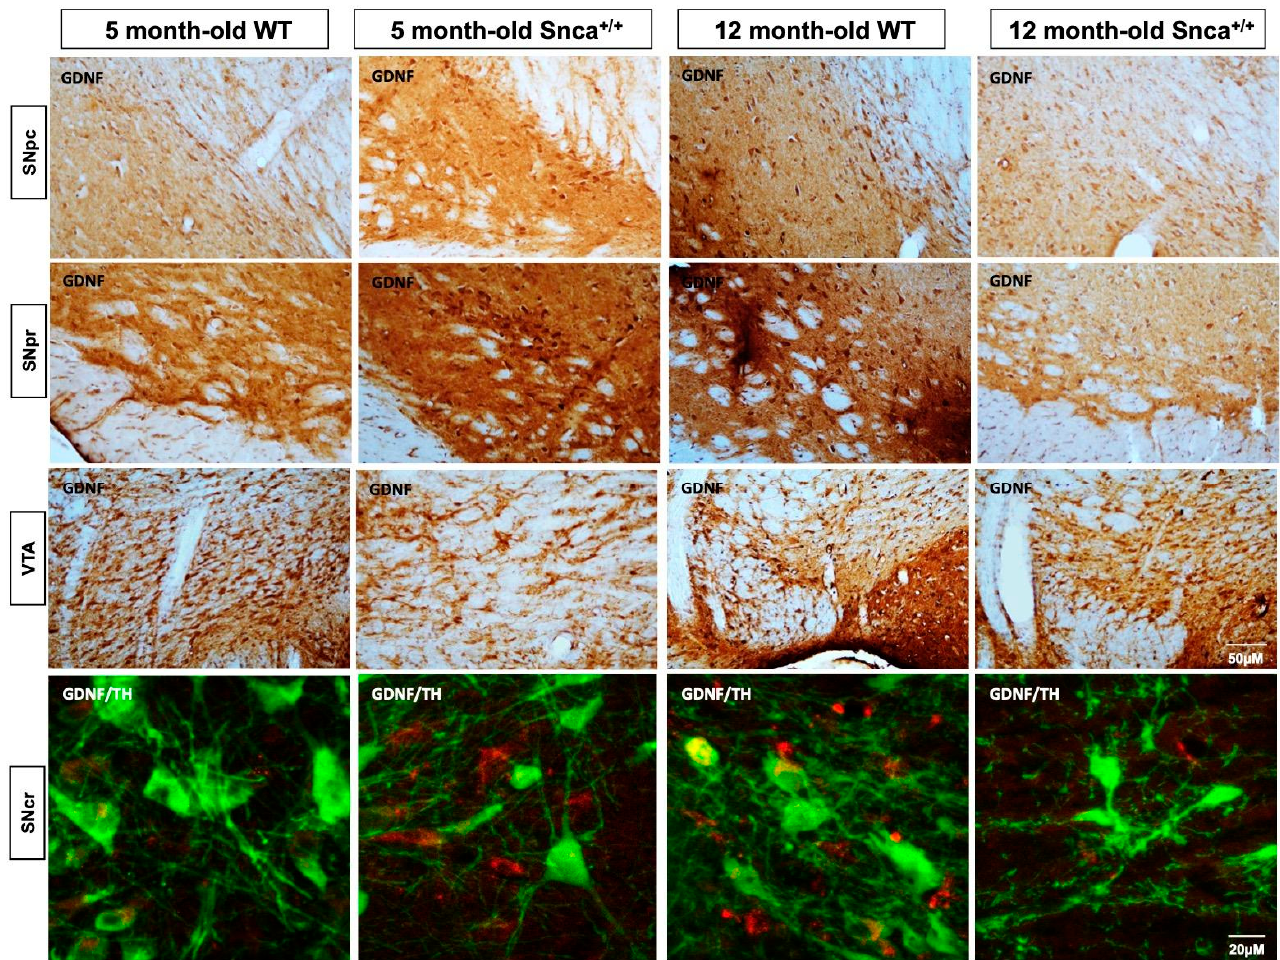
Figure 6. GDNF in the Snca +/+ Substantia Nigra. Representative photomicrograph of DAB immunohistochemistry for the marker GDNF in rats Substantia Nigra. A qualitative intensity of colorimetric reaction is observed in the SNpr of the 12-month-old WT rats. These data are confirmed by confocal z-stack images of a double immunofluorescence for GDNF and TH in which colocalization analysis show a Mander’s coefficient greater than 0.7 in 5 and 12-month-old Wt that is significantly reduced in 12-month-old Snca +/+ , in which it is less than 0.2.